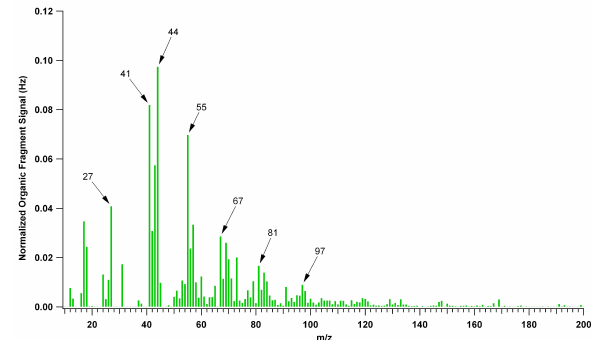
Figure 6. The average spectrum of the normalized organic mass spectra for the condensed organic mass ( COM ) on sulfate seed particles. The average spectrum was obtained for all the same experiments as those shown in Figure 2.